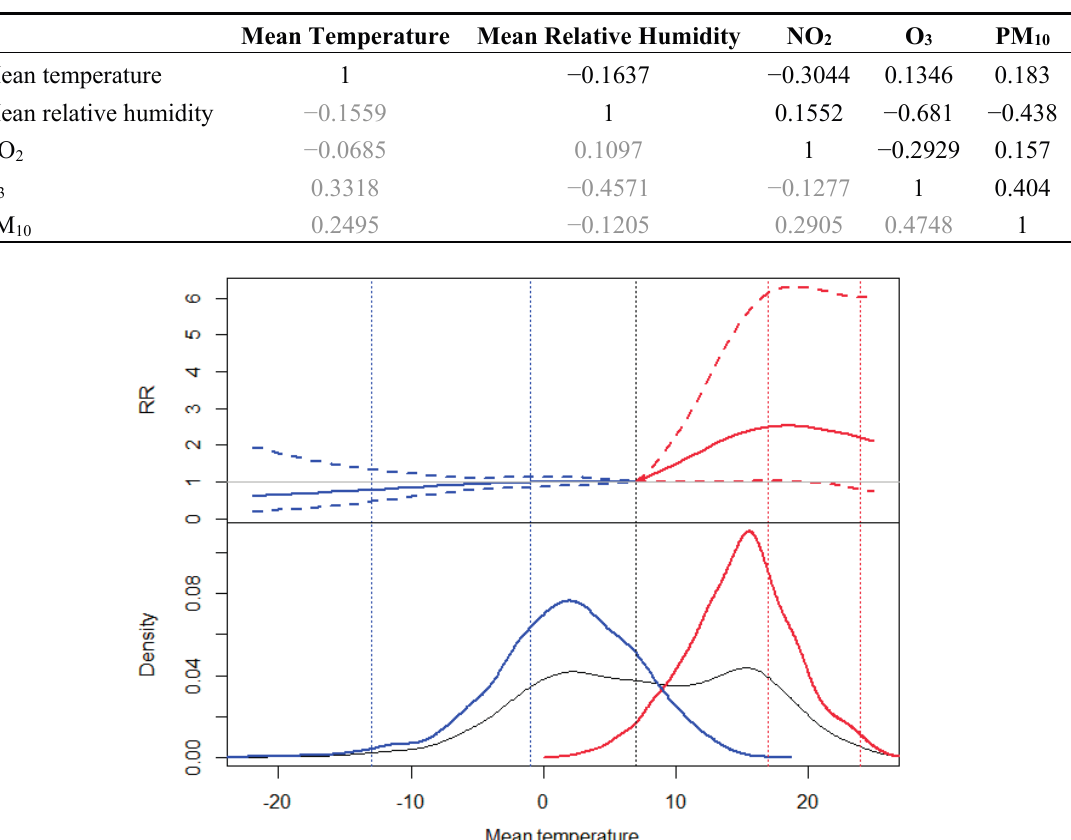
Figure 1. Top: Cumulative risk ratio (RR) and 95% confidence interval of preterm birth up to 30 days by mean temperature. Bottom: kernel distribution graphs of the mean temperature (Grey: entire annual period; Red: warm season; Blue: cold season). Vertical dashed lines in different mean temperature values: 1st and 25th percentile of the cold season (–13.1 °C; –1.5 °C), mean value of the entire annual series (black, long dash) (7.7 °C), and 75th and 99th percentile of the warm season (17.5 °C; 24